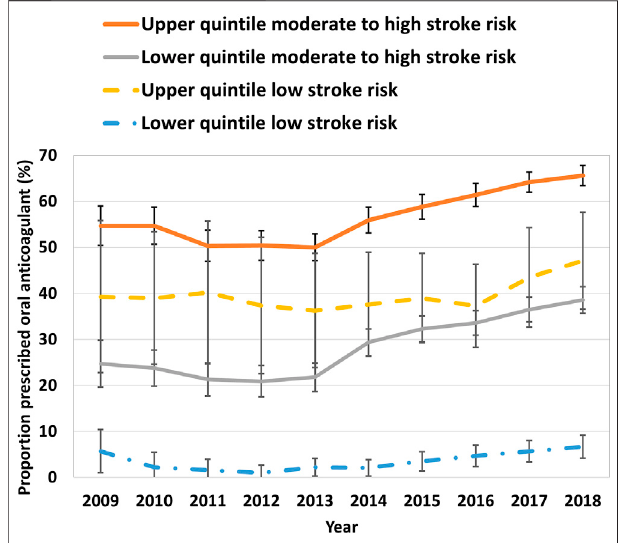
FIGURE 2 | Practice site prescribing-performance quintile in moderate to high stroke risk patients with atrial fi brillation, 2009 – 2018. Error bars indicate 95% con fi dence